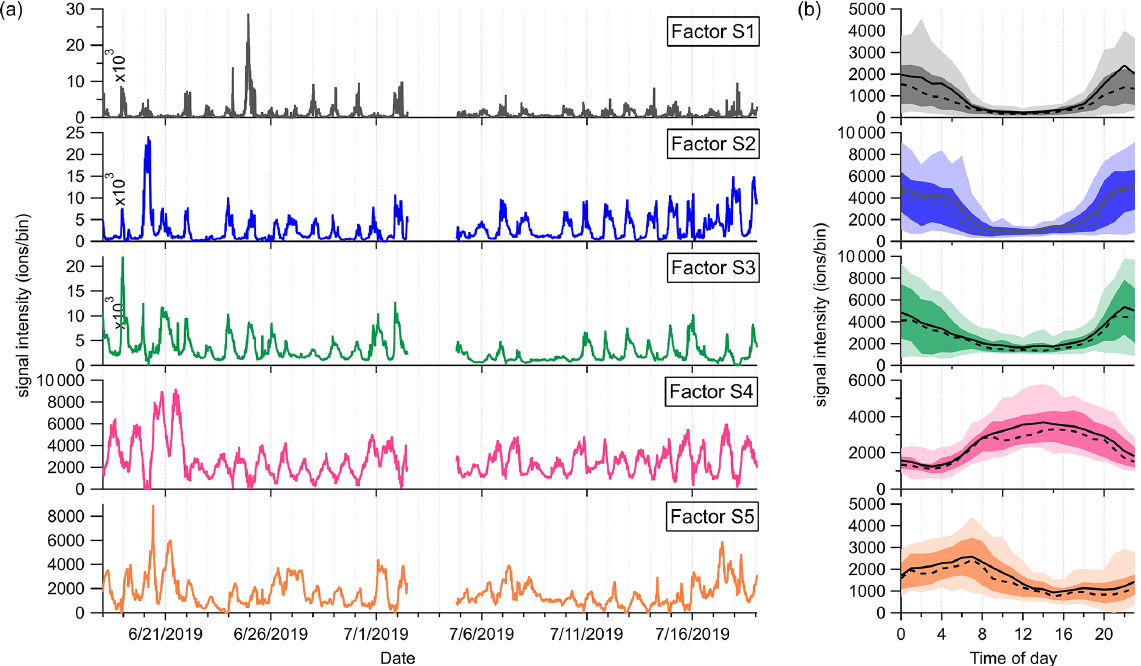
Figure 8. (a) Time series and (b) diurnal cycles of the five factors in the low-mass range at the SMEAR II station. The solid and dashed lines in the diurnal plots show the mean and median values, respectively, and the shaded area shows 10th, 25th, 75th, and 90th percentiles.